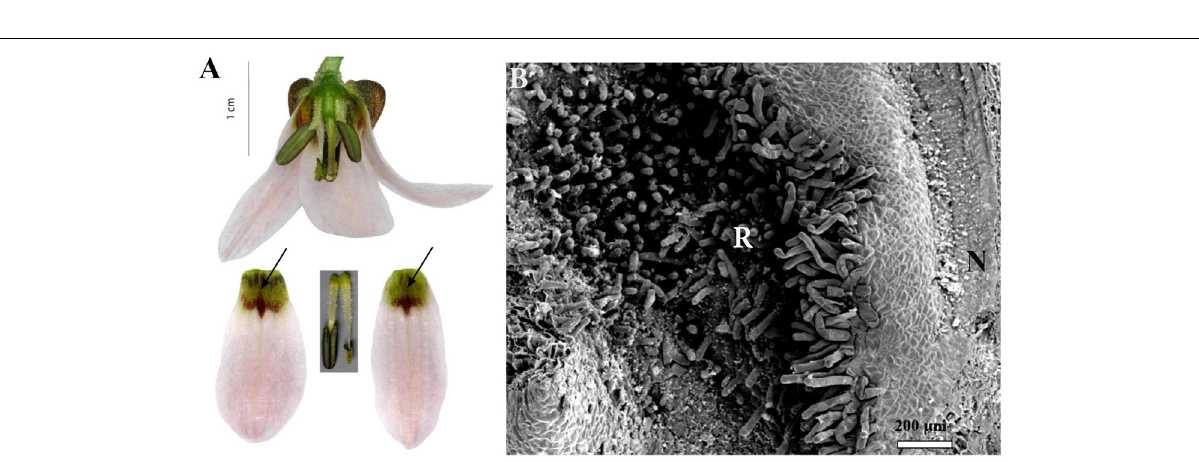
FIGURE 11 | Flowers and nectaries of F. stenanthera . Macro and SEM images. (A) Flowers and tepals, nectaries marked with arrows. (B) Part of outer tepal showing deeply depressed spurs nectary (N), protected by densely papillose ridges (R).